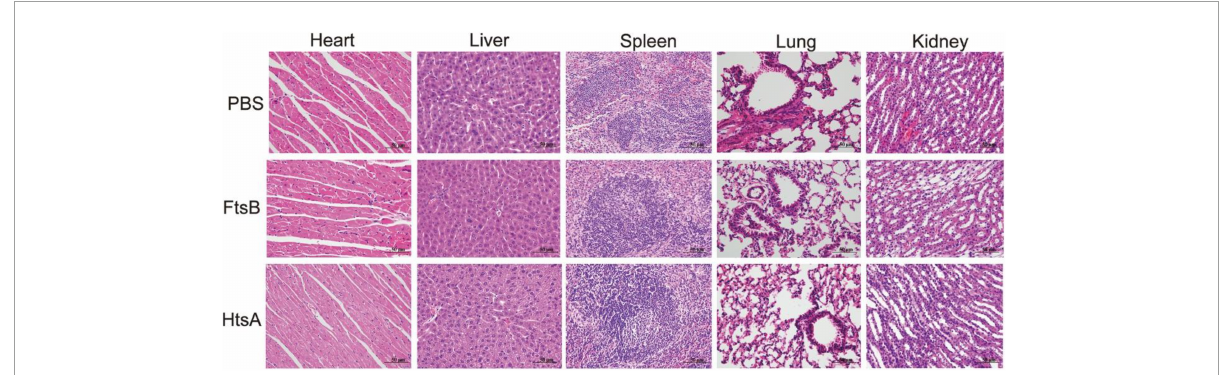
FIGURE4 Immunization with the FtsB protein decreased the pathology of the heart, liver, spleen, lung, and kidney in a murine bacteremia model. HE images of the heart, liver, spleen, lung, and kidney in mice 48 h after challenge with 5 × 10 6 S. pyogenes MGAS5005 (400 × ).